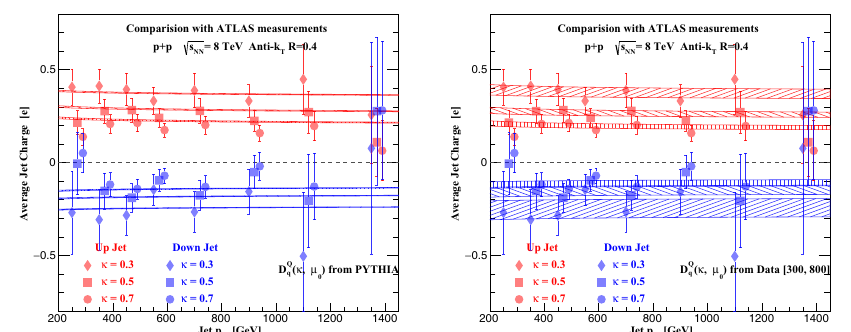
Figure 1. Average charge of up and down-quark jet as a function of jet p T with κ = 0.3, 0.5 and 0.7 in √ s NN = 8 TeV p + p collisions. The dots with error bars represent the measurements by ATLAS [4]. The red and blue bands are the predictions with the non-perturbative parameters obtained through fitting to PYTHIA simulations (left) and ATLAS measurements (right).